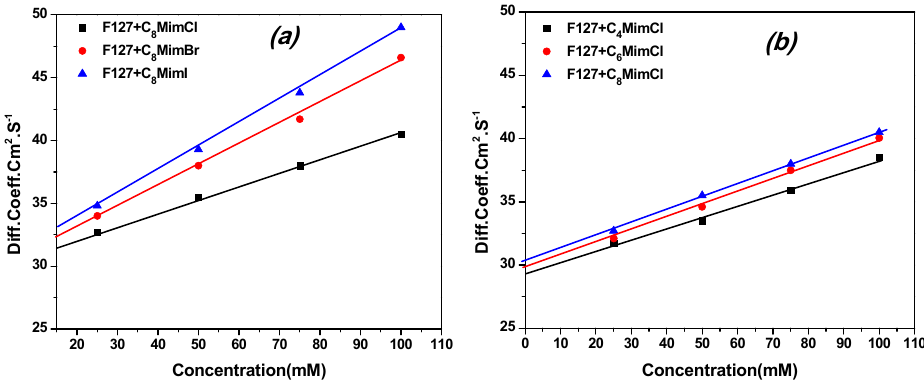
Figure 1. DLS curves for F127 micelles in presence of IL ( a ) effect of anions and ( b ) effect of alkyl chain length on micellization. Table 1. Parameters obtained from DLS measurements.